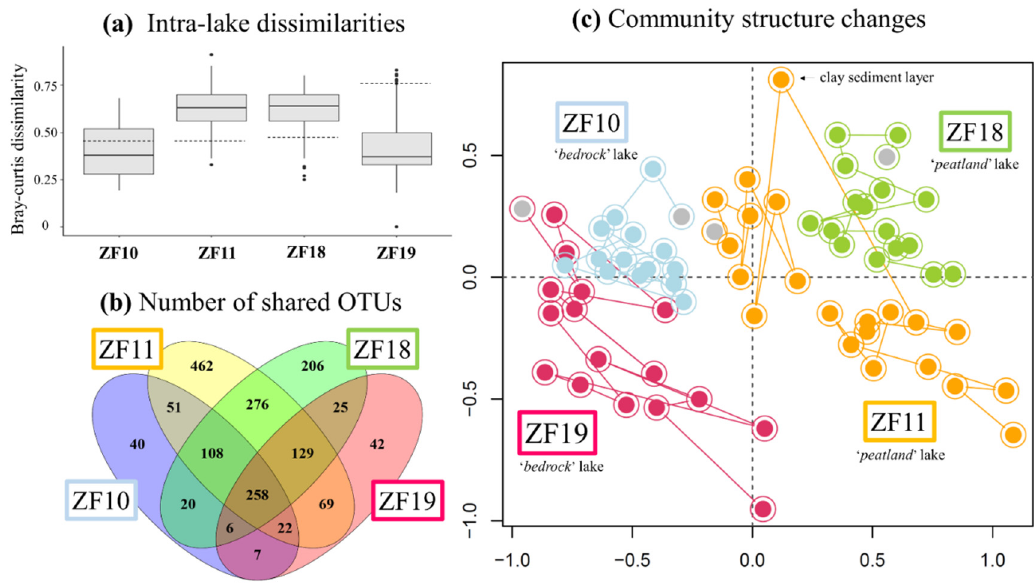
Figure 2. ( a ) Boxplots showing the amplitude of changes between depths (ages) for each lake in terms of the Bray-Curtis dissimilarities. Hatched bars correspond to the Bray-Curtis dissimilarity values measured between the oldest sediment sample and the second-oldest sediment sample for each sediment core. ( b ) Venn-diagram illustrating the numbers of Operational Taxonomic Units (OTUs) common to the four lakes, between each pair of lakes and specific to each lake. ( c ) Temporal changes in the microbial eukaryotic community in sediments from the four lakes. The nonmetric multidimen- sional scaling (nMDS) is based on the Bray-Curtis dissimilarity values calculated from the table of standardized OTU relative abundances. The colors denote the respective lake. The oldest sediment samples from each time series are highlighted in gray. The position of the molecular inventory corresponding to the clay layer in the ZF11 sediment profile was displayed in the nMDS plot.